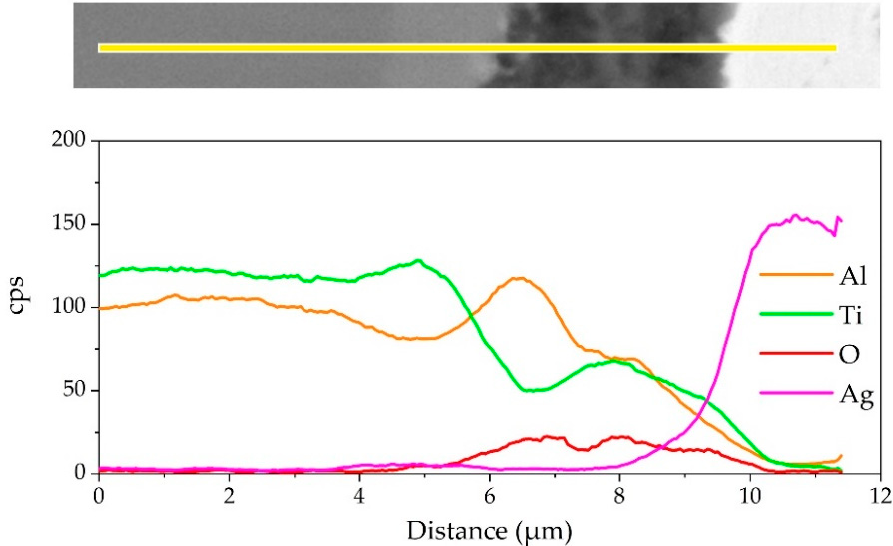
Figure 9. EDS line scanning result of the joint interface.